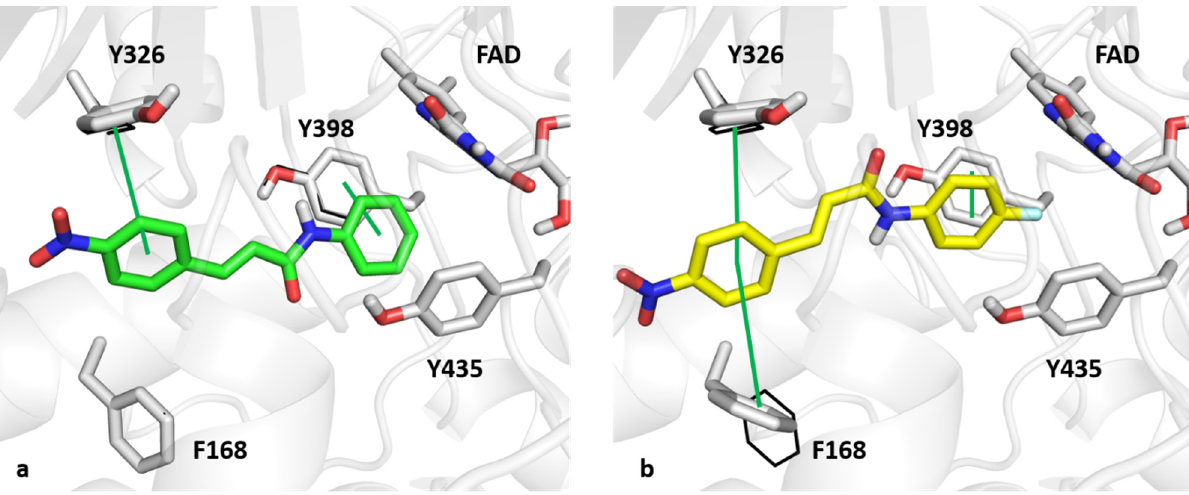
Figure 4. The best-docked poses of compounds NEA1 ( a , green sticks) and NEA3 ( b , yellow sticks) in a MAO-B binding pocket. Green lines indicate p–p contacts. Black wireframes report the original pose of MAO-B sidechains within the binding site.